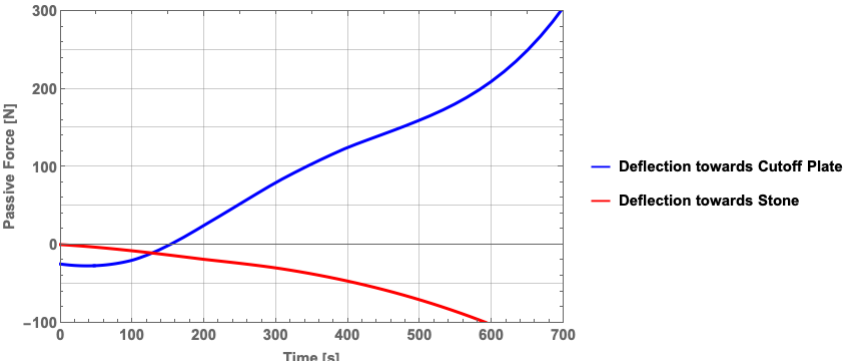
Figure 12. Average passive force for ( blue ) band deflection towards the plate being cut ( red ) band deflection towards the remaining block of